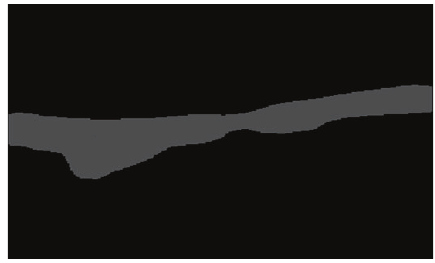
Figure 3: Extracted vessel wall.